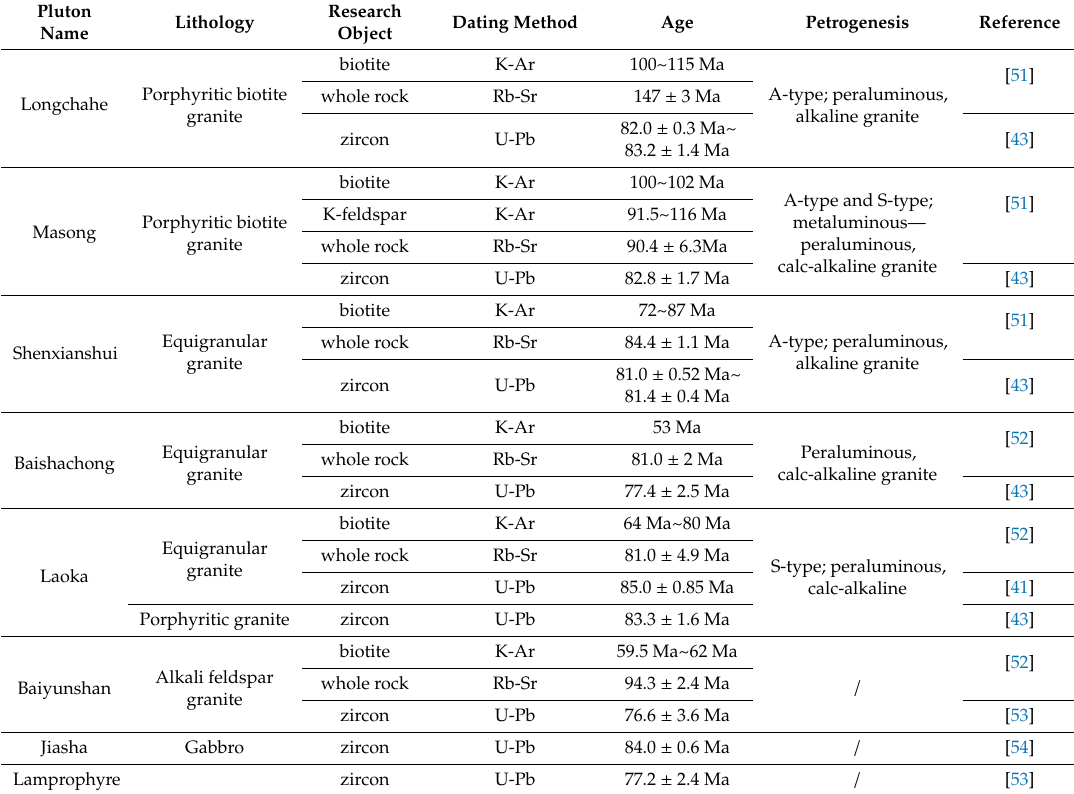
Table 1. The ages of magmatic intrusions in Gejiu